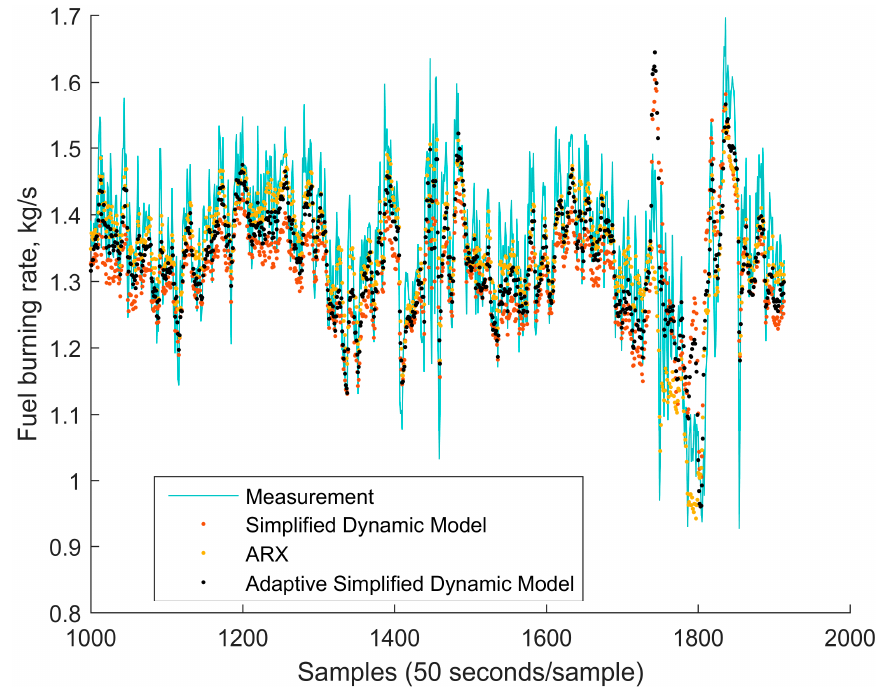
Figure 12. Comparison of burning rates predicted by the simplified dynamic model, ARX, and the adaptive simplified dynamic model.